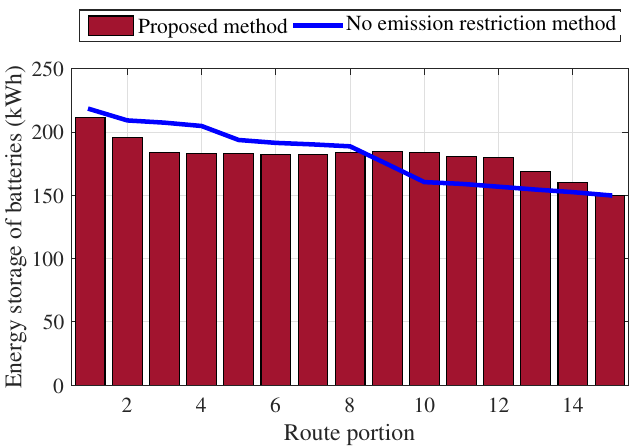
Figure 9. Energy storage of batteries at different route